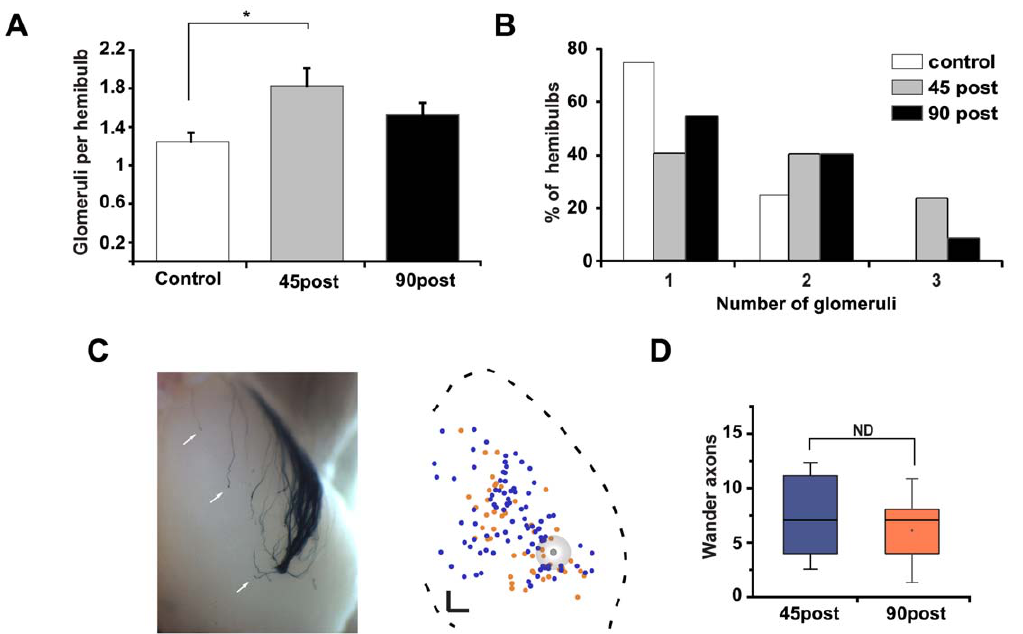
Figure 4. No refinement of glomerular circuits after regeneration. A , The mean number of lateral glomeruli increased 45 days after methimazole administration (* denotes P , 0.05). No evident refinement of glomeruli is observed 90 days after methimazole exposure ( P . 0.05). B , Percentage of hemibulbs showing the indicated number of glomeruli. C , Image of dorsal bulb from regenerated mice (left) and normalized plane with the distribution of miss routed axons at 45 (blue dots) and 90 (orange dots) days post lesion (right). D , Box plot of the number of miss routed axons. Mean 6 SEM are represented. Scale bar 200 m m, (ND, no difference).